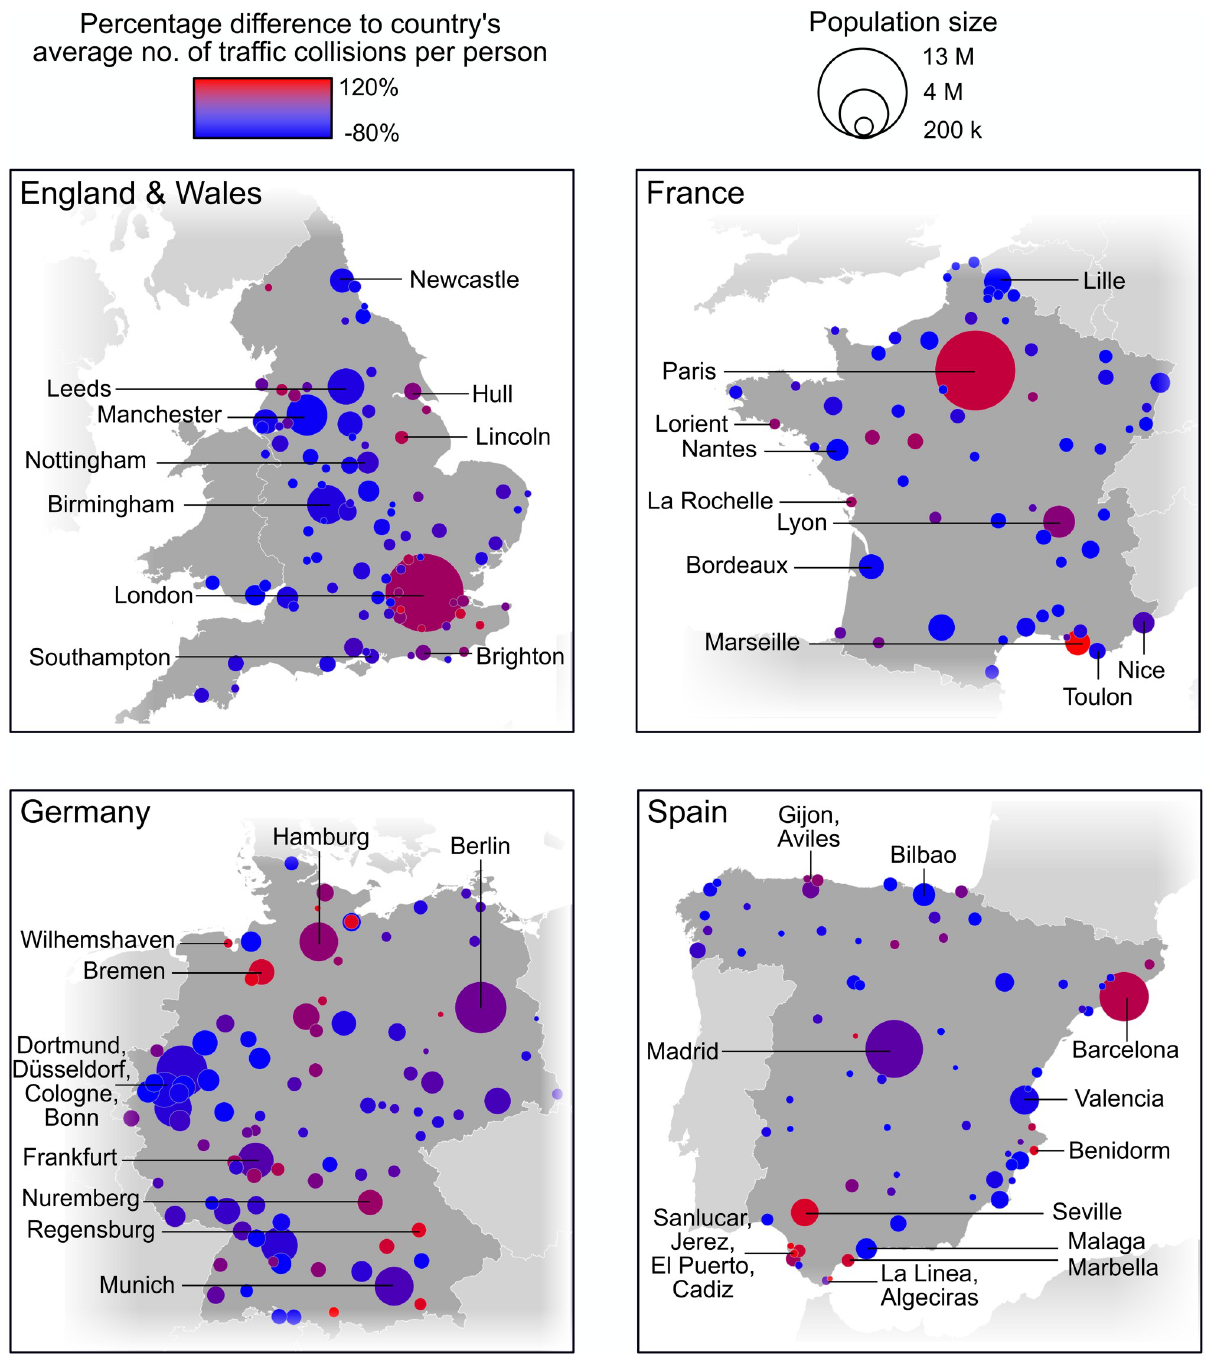
Fig 1. Map representation of the number of road traffic collisions per person in urban areas from England and Wales, France, Germany and Spain.